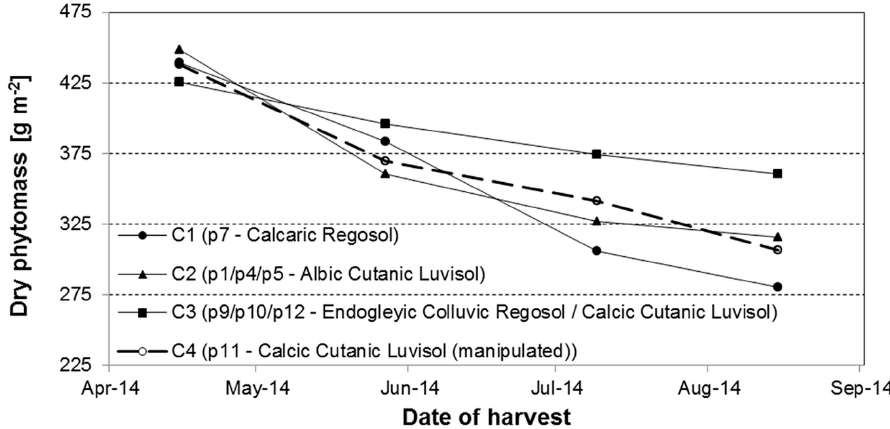
Figure 19. Temporal decline of above ground dry phytomass of lucerne between the first and fourth harvest in 2014. Table 4. Yearly estimates of dry phytomass production and C export from four different Terrain/Soil type combinations (C1–C4) calculated from UAV imagery and ground based monitoring